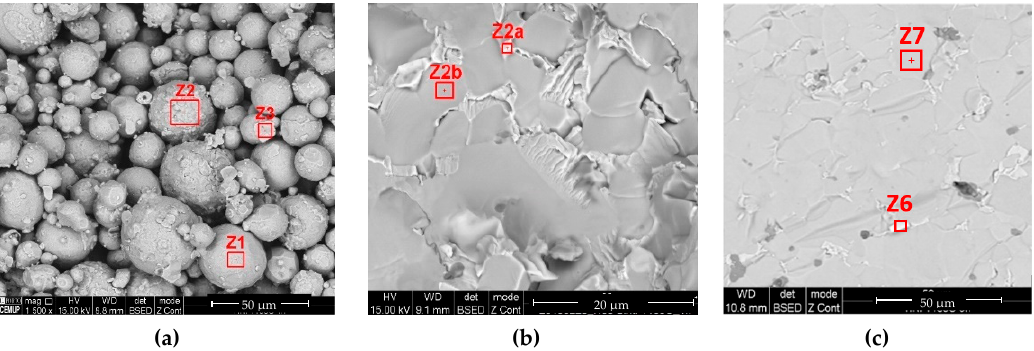
◦ C (1 h), ( b ) 1165 ◦ C (1 h), and ( c ) 1165 ◦ C (5 h). Figure 10. Specimens sintered at ( a ) 1100 °C (1 h), ( b ) 1165 °C (1 h), and ( c ) 1165 °C (5 h). Figure 10. Specimens sintered at ( a ) 1100